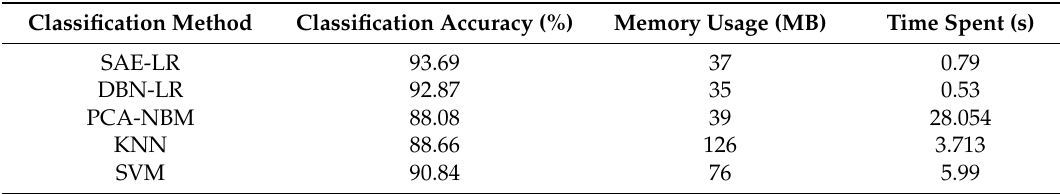
Table 1. Classification accuracy of different classification algorithms.